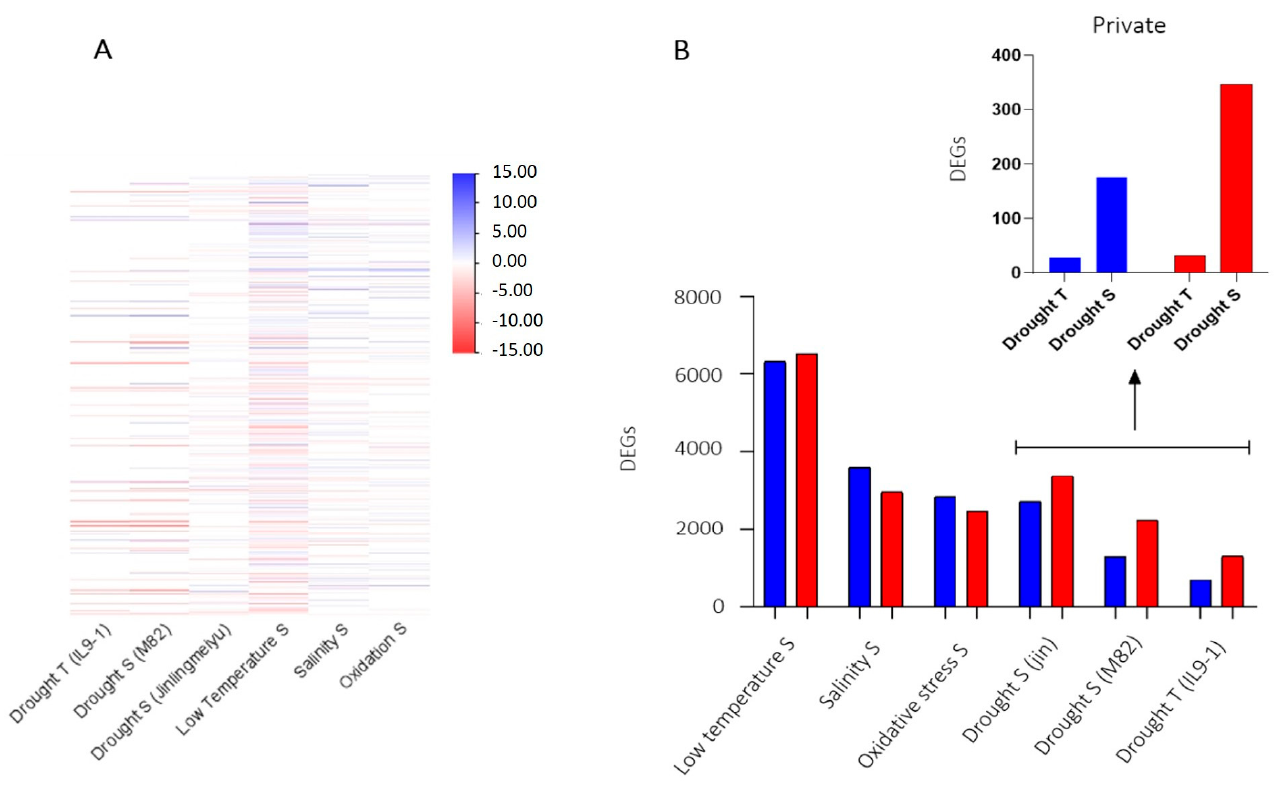
Figure 6. ( A ) Heatmap of DEGs induced during different abiotic stress; ( B ) Number of DEGs induced by different abiotic stress with a focus on private DEGs induced by tolerant and susceptible geno- types to drought. Blue = Upregulated and Red = Downregulated . R= resistant; S= susceptible; T= tolerant